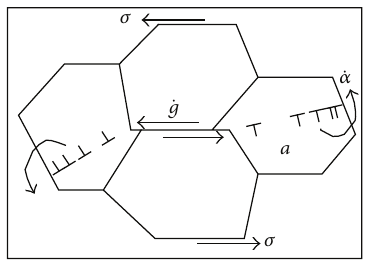
Figure 1: A rheological model representing the GBS accommodated by GMD [5].